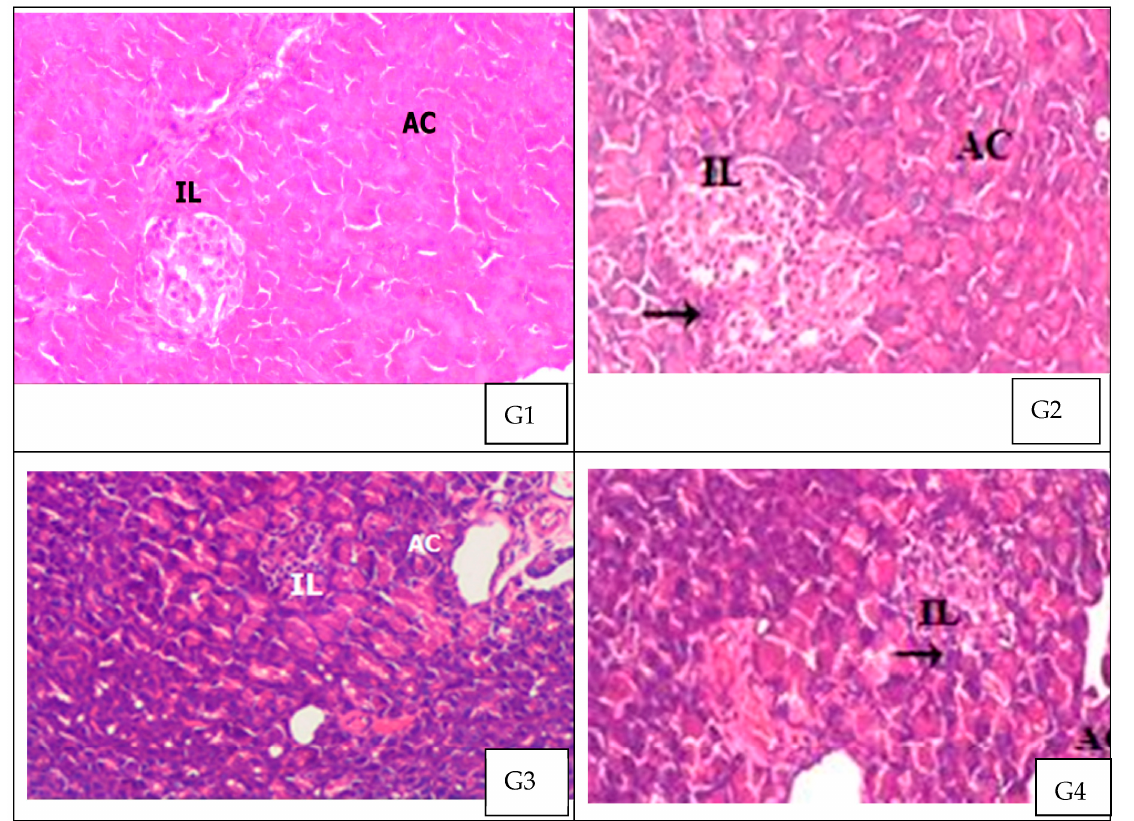
Figure 6. Photomicrograph of the pancreatic tissue stained with hematoxylin and eosin for the various treatment groups: ( G1 ) control rats, ( G2 ) rats that received S. linifolium phlorotannins extract, ( G3 ) diabetic rats administered streptozotocin, and ( G4 ) diabetic rats treated with S. linifolium phlorotannin extract.